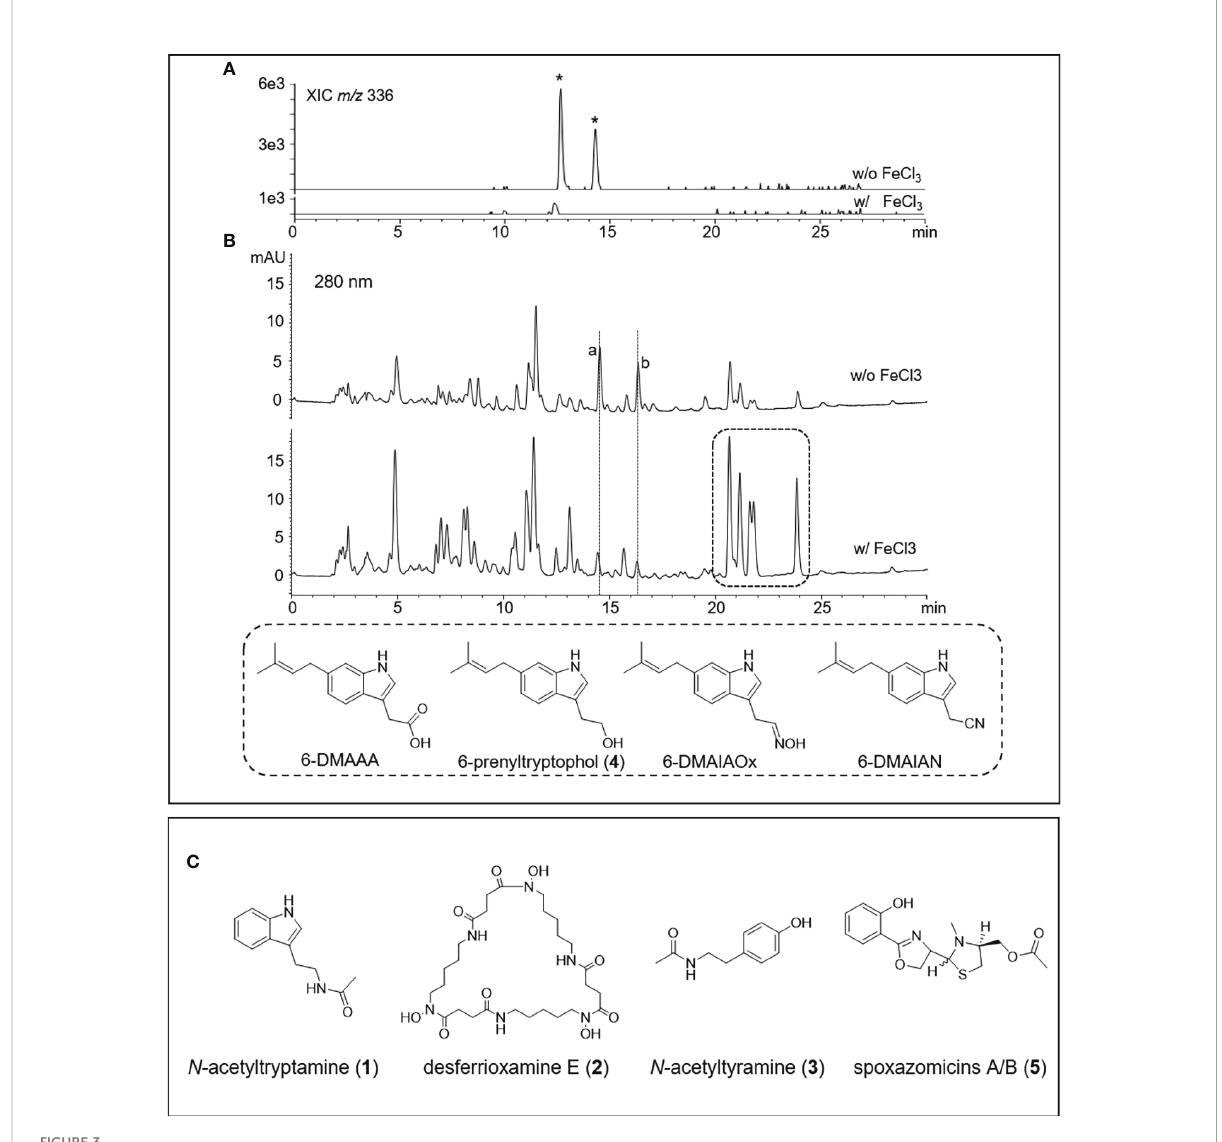
FIGURE 3 HPLC-MS chromatograms of V17-9 culture extracts of normal culture and ferric ion supplied culture and isolated compounds from V17-9. (A) When ferric ions were supplied as FeCl 3 , two compounds labeled with an asterisk with identical molecular ions ( m / z 336) were depleted and subsequently identi fi ed as spoxazomicins A and B after isolation and puri fi cation. (B) Along with spoxazomicins, additional two compounds with the same UV absorption spectrum (a, b) disappeared under cultivation supplied with FeCl 3 , and indole compounds (6-dimethylallylindole-3- acetic acid (6-DMAAA, monaprenylindole A), 6-dimethylallylindole-3-acetonitrile (6-DMAIAN), and 6-dimethylallylindole-3-acetaldoxime (6- DMAIAOx) in the dashed box increased. Peaks were observed at similar retention times, but the peaks were different molecules from a and b based on UV and mass spectra. The compounds corresponding to a and b were expected as germicidins based on their UV absorption spectrum and mass-to-charge ratio ( m / z ). (C) Chemical structures of the compounds isolated from the culture extract of V17-9, N - acetyltryptamine (1), desferrioxamine E (2), N -acetyltyramine (3), and spoxazomicins A and B